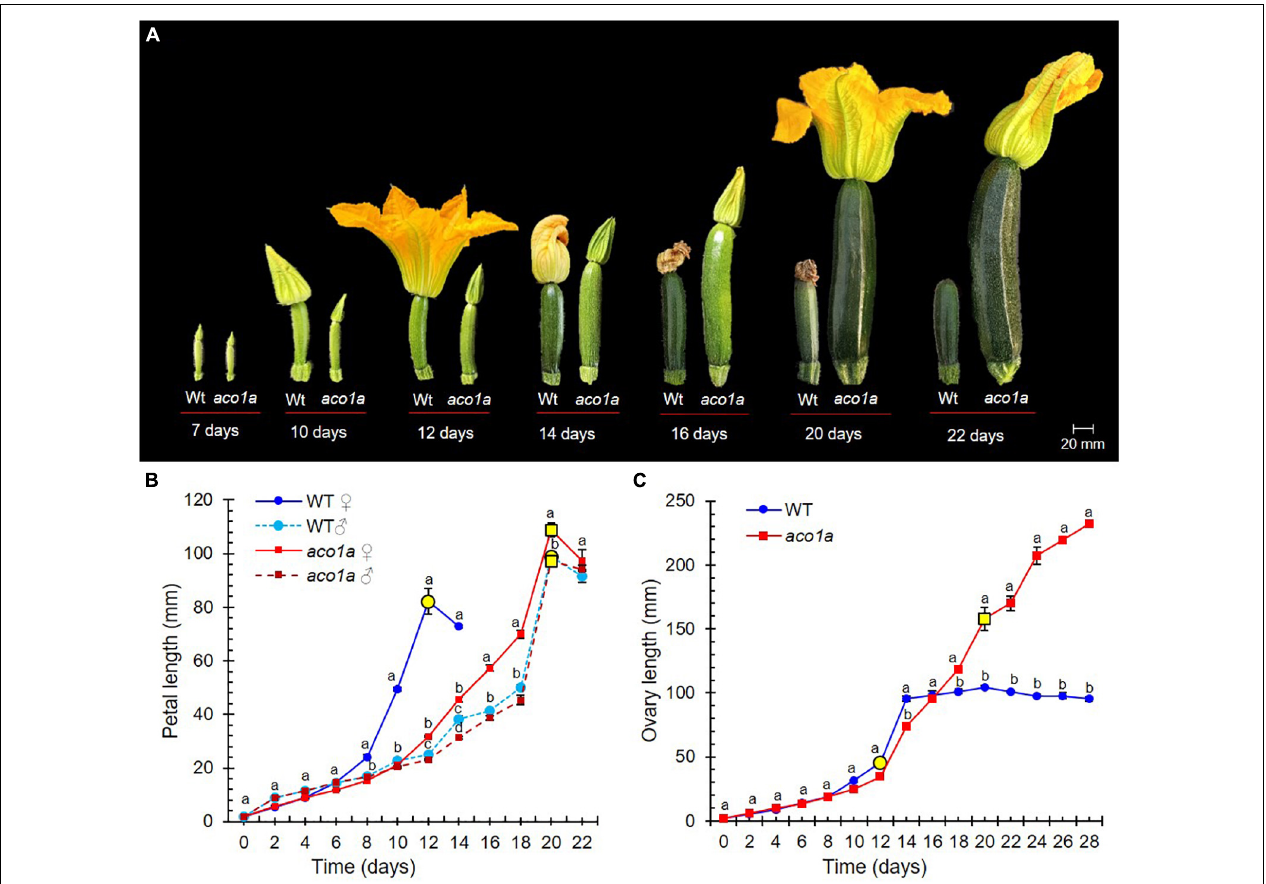
FIGURE 2 | Comparison of WT and aco1a flower development. (A) Effect of aco1a mutation on the development of ovary and corolla of the pistillate flower. Note that the mutant pistillate flower reaches anthesis later than the WT, and that the ovary continues its growth until producing a parthenocarpic fruit. (B) Comparison of the growth rate of WT and mutant corolla. Flowers were labeled when their ovaries were 2 mm long, and then measured every 2 days for 22 days. Yellow circles indicate the time at which more than 80% of the flowers reached anthesis. (C) Comparison of the growth rate of WT and mutant ovaries/fruits over a period of 22 days. Error bars represent SE. Different letters indicate significant differences in flowers of the different genotypes at each developmental time ( p ≤